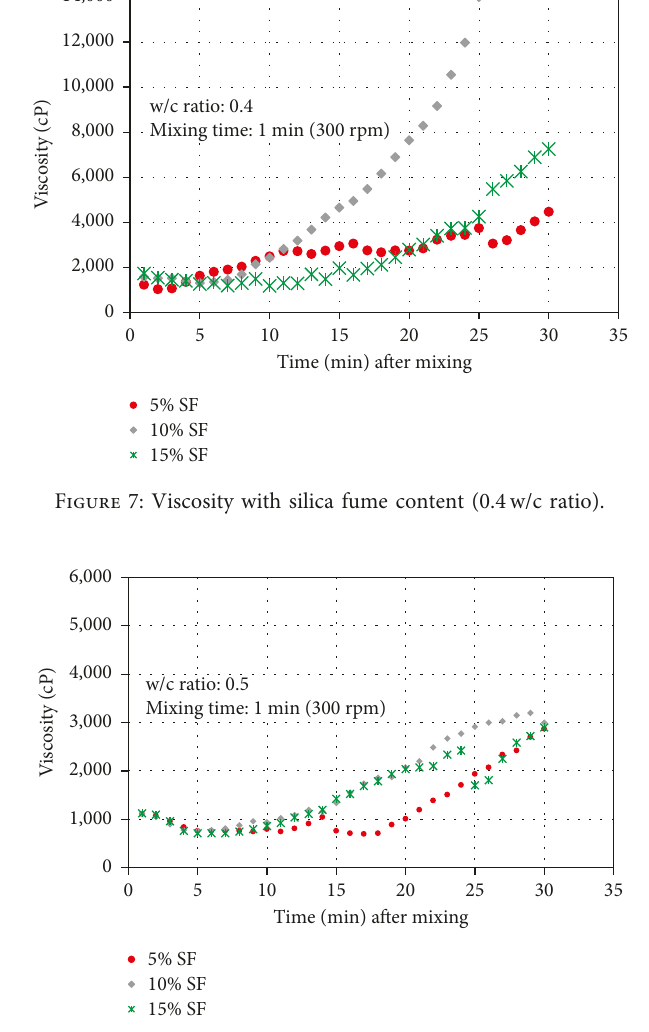
Figure 8: Viscosity with silica fume content (0.5w/c